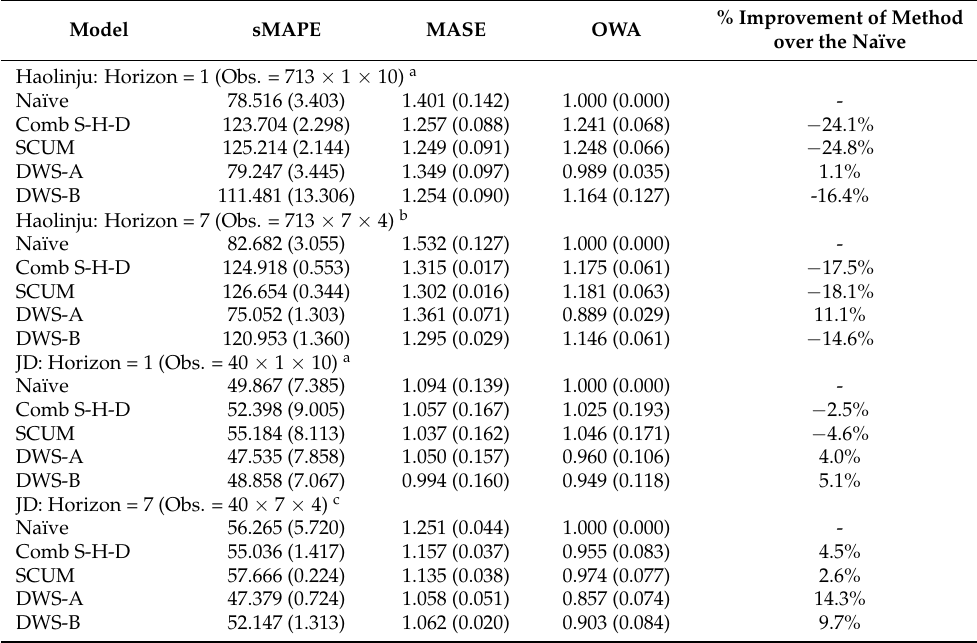
% Improvement of Method over the Naïve